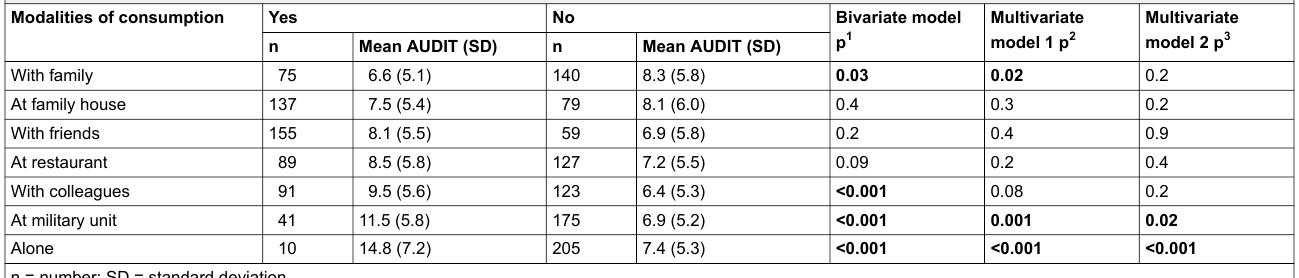
Table 1: Variations in scores of alcohol use disorders identification test (AUDIT) according to alcohol modalities of consumption – Multiple linear regression.